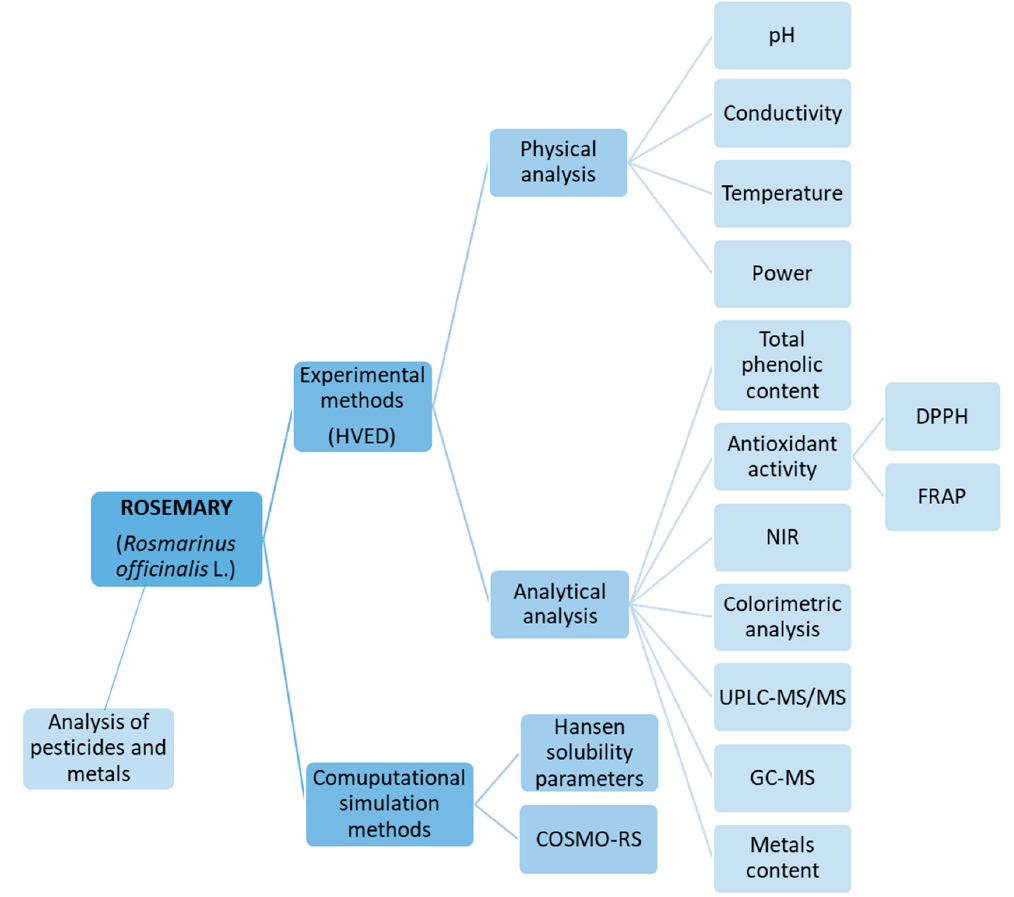
Figure 1. Flowchart of performed analysis in the paper.